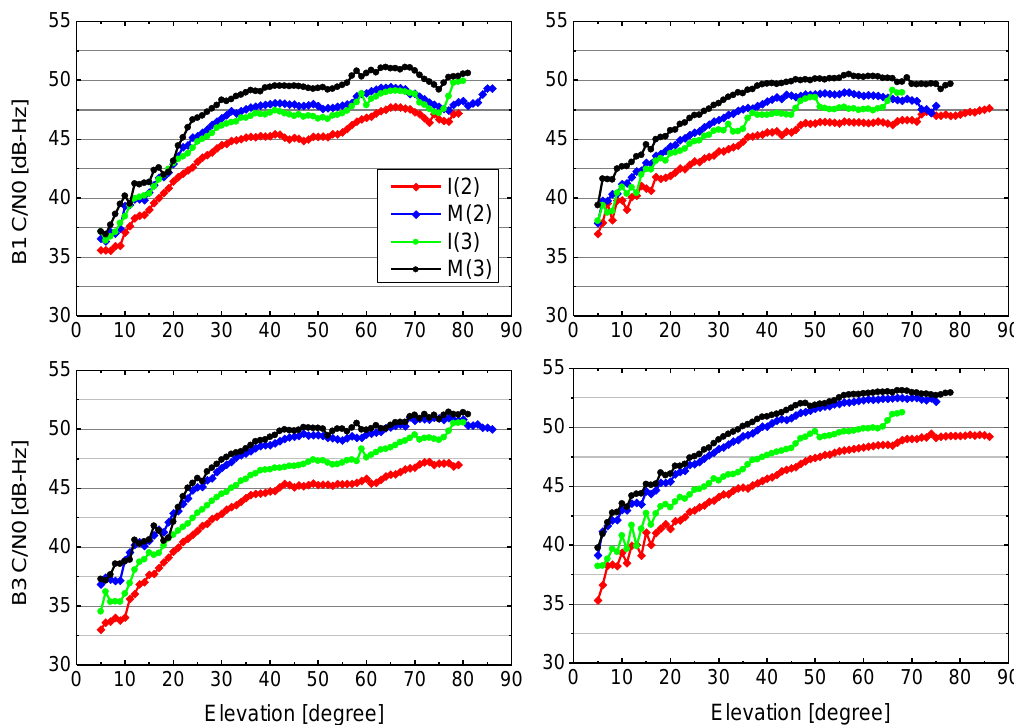
Figure 3. Mean C/N0 values as a function of elevation for BDS-2 and BDS-3 IGSO and MEO satellites signals at site BJF1 equipped with GMR-4011 receiver with LEIAR25.R4 antenna (left) and site KUNU equipped with POLARX5 receiver with JAVRINGANT_DM antenna (right) during DOY 204-221, 2016. The upper and bottom panels show the results of B1 and B3 frequencies, respectively.